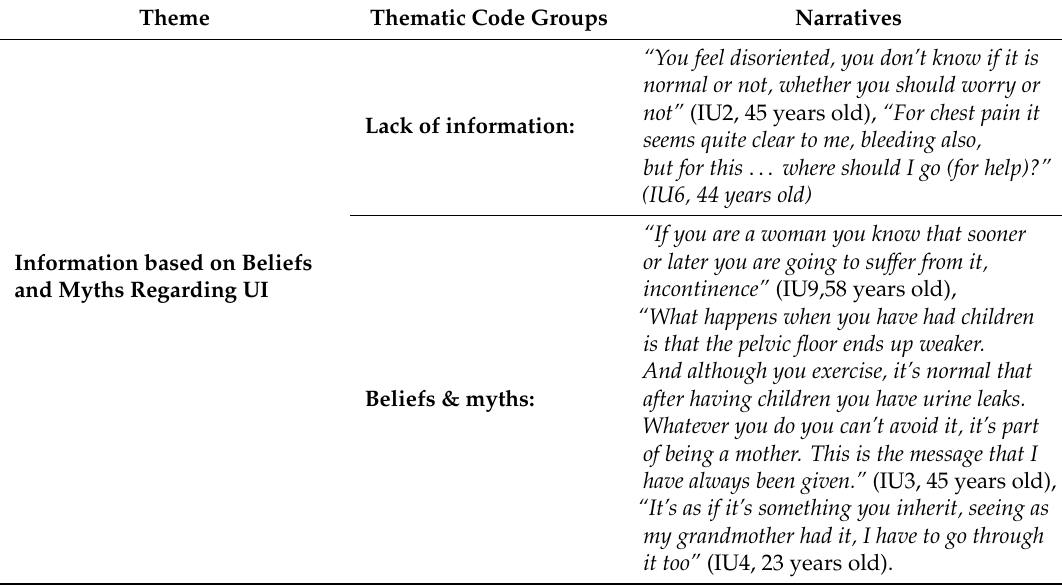
Table 4. Participants’ narratives from the theme: Information based on Beliefs and Myths Regarding